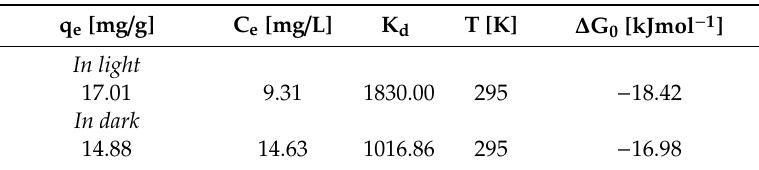
Table 2. The values of the distribution coe ffi cient and the Gibbs free energy change of the metal ions sorption in light and dark conditions.